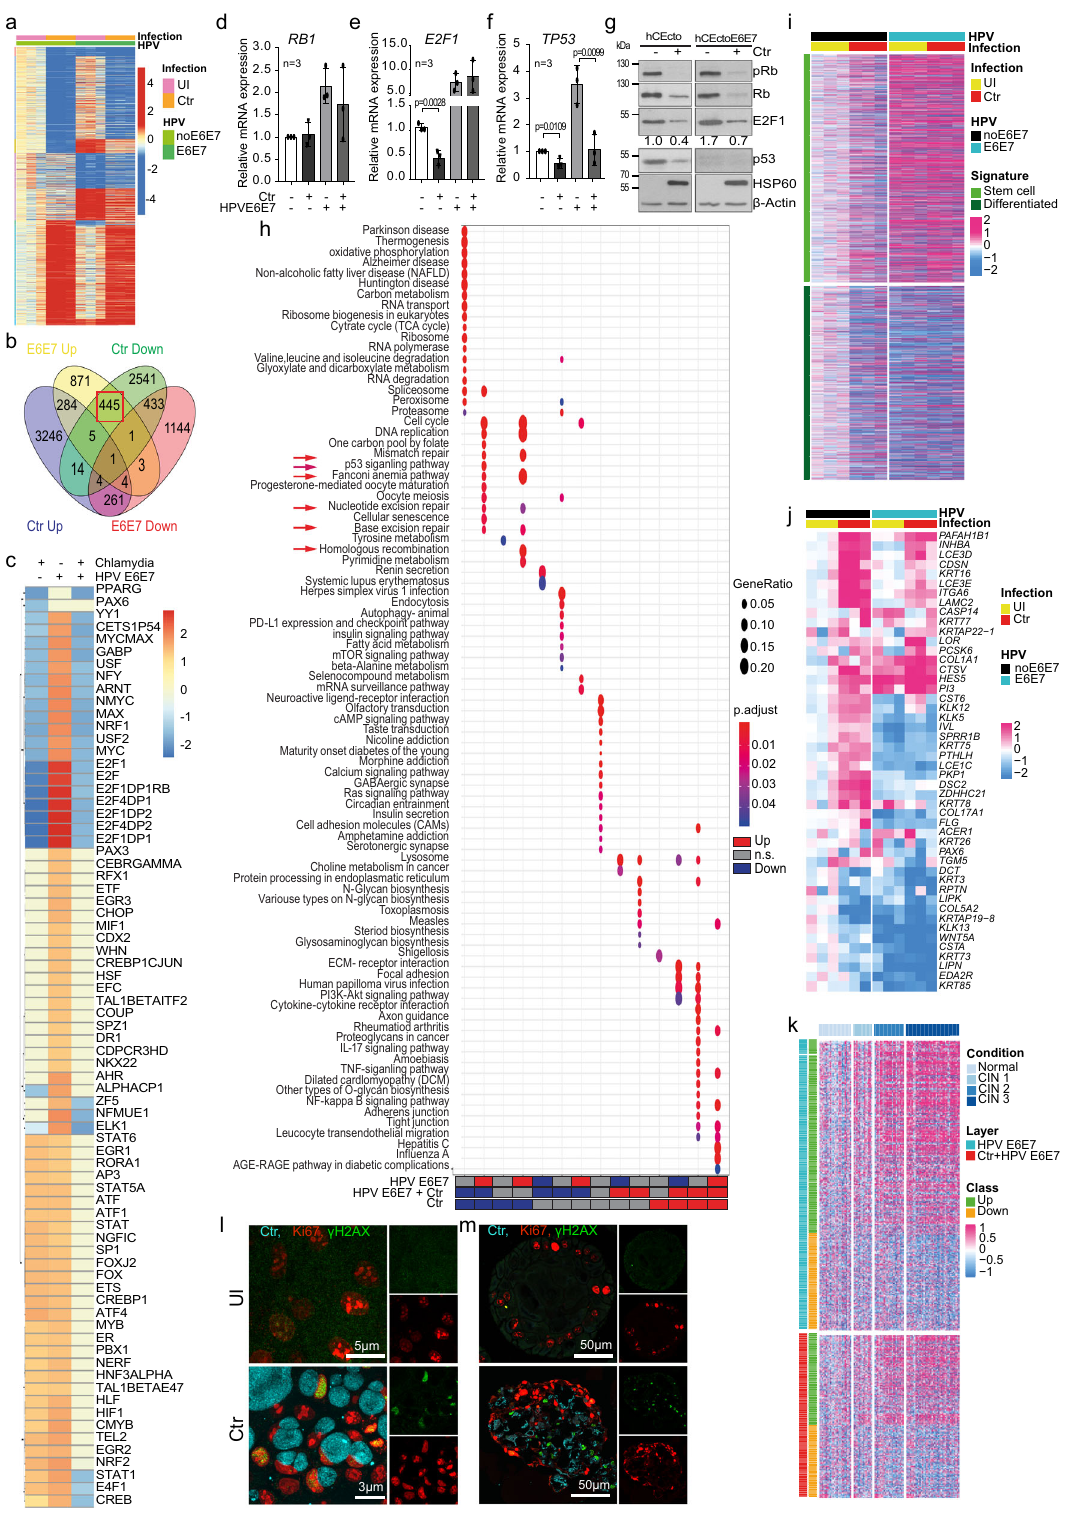
gene expression induced by HPV E6E7 and Chlamydia infections. We found that HPV E6E7 and Chlamydia infection both upregulate genes associated with stemness and down-regulate differentiation-associated genes (Fig. 3i). Further, we extracted the genes associated with skin development, epidermis develop- ment, keratinocyte differentiation, keratinization, epidermal cell differentiation, and corni fi cation GO terms that were oppositely